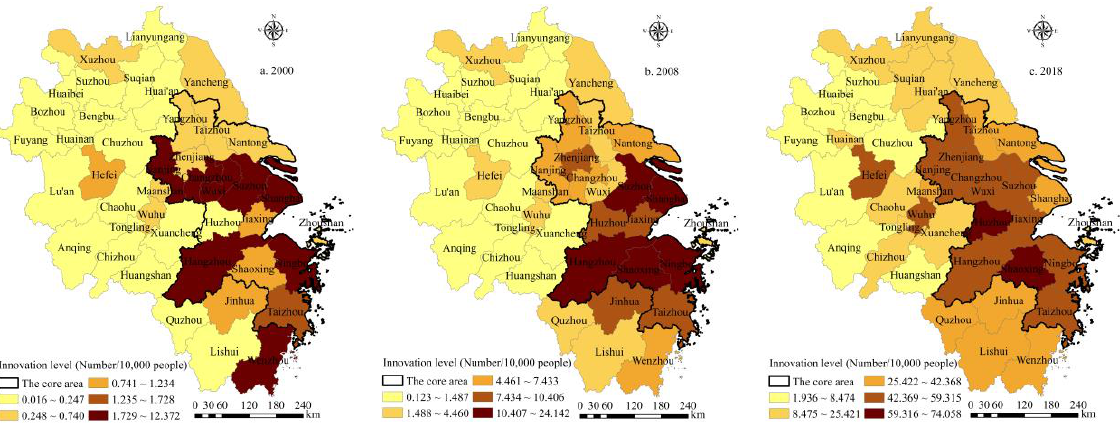
Figure 4. Evolution of the spatial and temporal patterns of innovation in the YRD from 2000 to 2018.